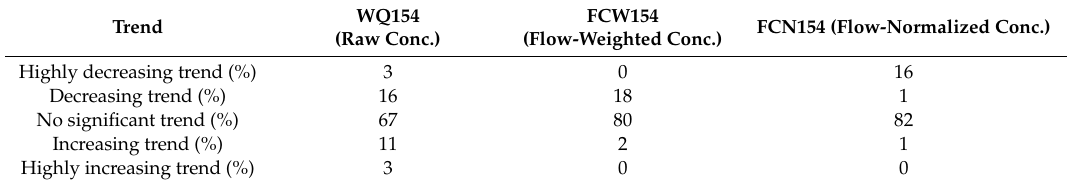
Table 6. Trend analysis of annual nitrate concentration using raw, flow-weighted and flow-normalized concentrations (conc.) using the MSD trend test (period 2008–2011 and 2012–2015) per class of trend of the Nitrates